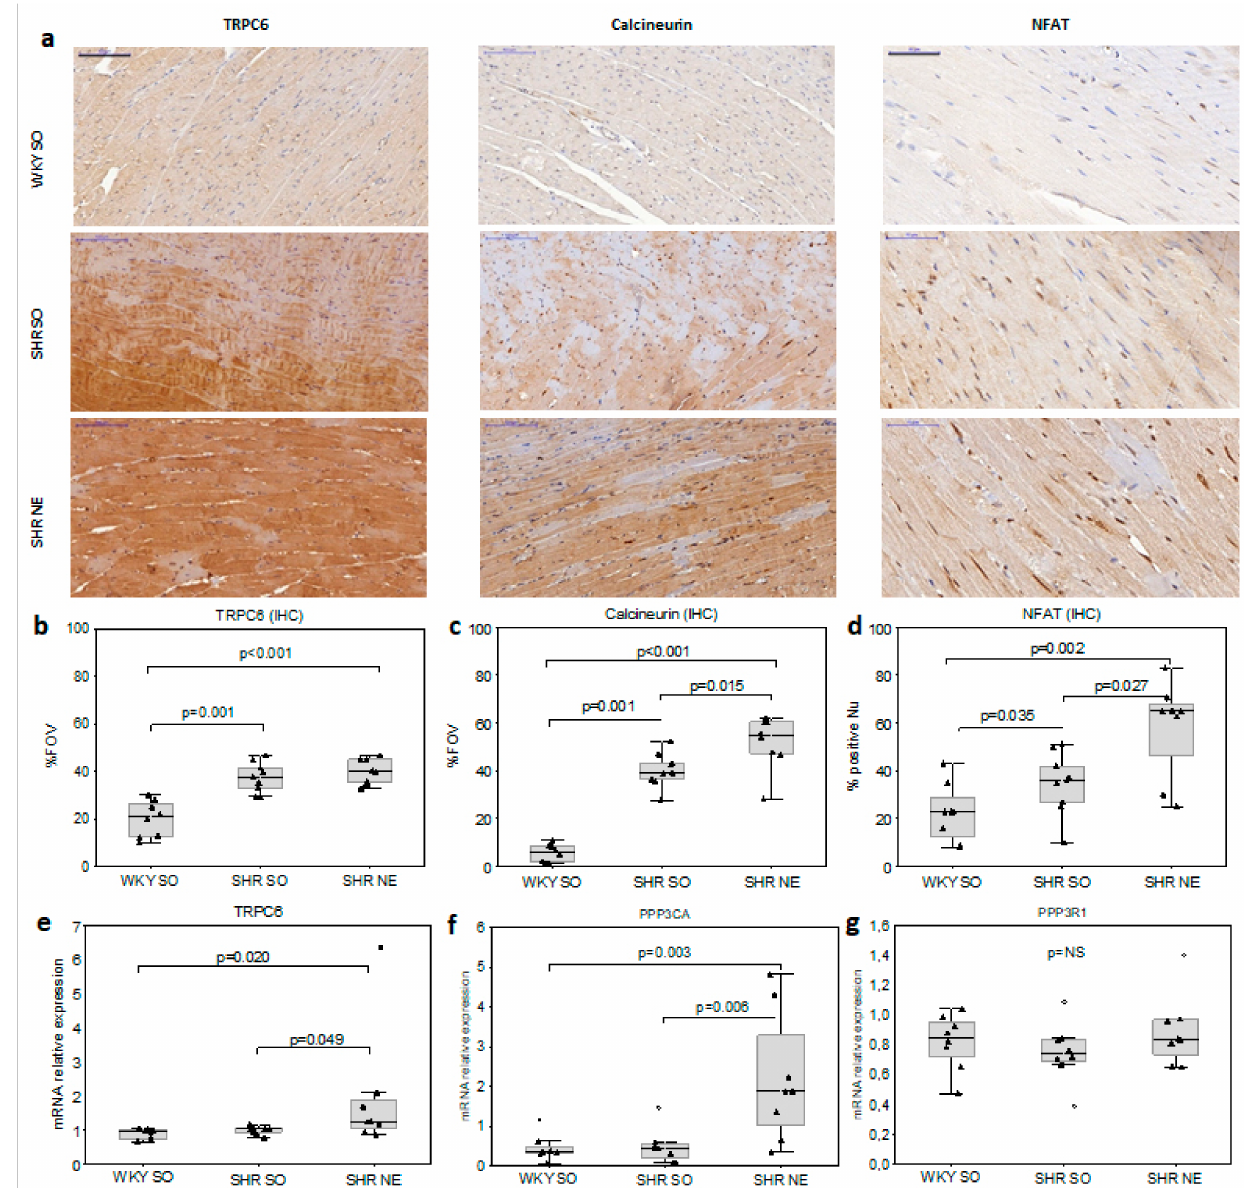
Figure 3. Myocardial expression of calcineurin/NFAT and TRPC6: ( a ) the representative microphotographs of the myocar- dial expression of TRPC6/CaN/NFAT; the morphometric analysis of myocardial ( b ) TRPC6 (200 × ; scale bar, 100 µ m), ( c ) CaN (200 × ), and ( d ) nuclear NFATc3 (400 × ; scale bar, 50 µ m) IHC staining; and ( c ) the relative mRNA expression of ( e ) Trpc6 , ( f ) calcineurin A ( Ppp3ca ) and ( g ) calcineurin B ( Ppp3r1 ) in controls, hypertension, and renal dysfunction; FOV—field of view;